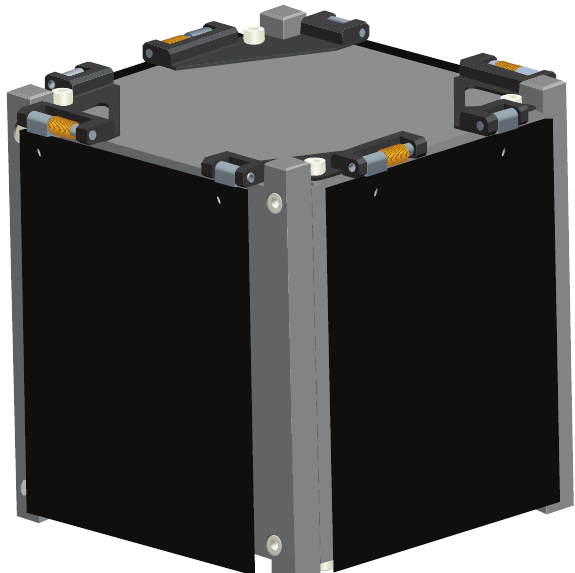
Figure 1: Model of PilsenCUBE picosatellite [2] based on CubeSat